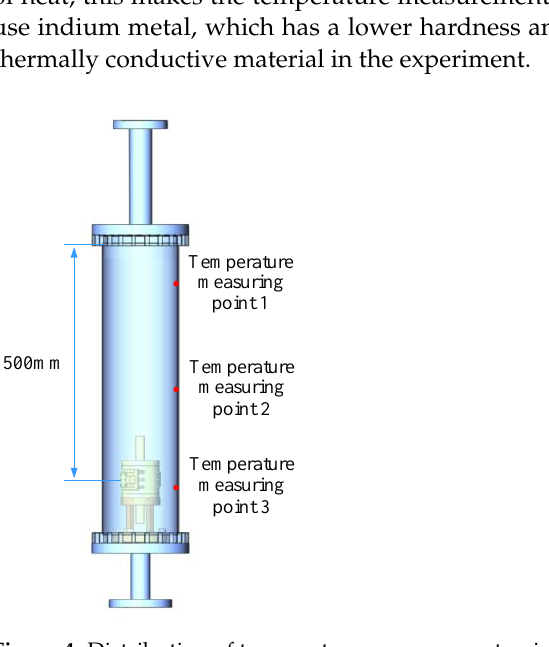
Figure 4. Distribution of temperature measurement points of the system.